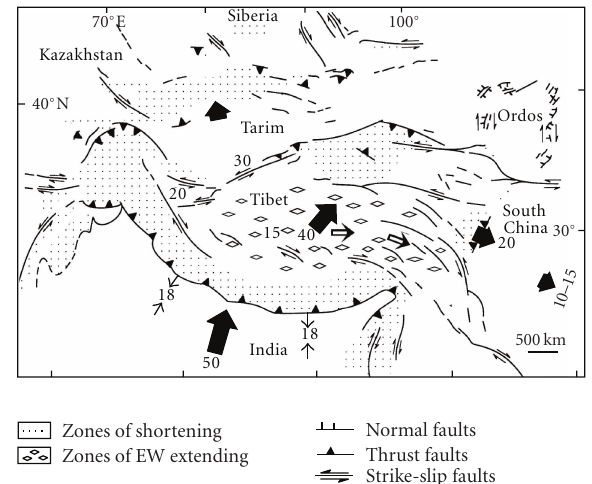
Figure 11: Eeastward extension regions on the central Tibetan plateau. Open rhomb area: extensional motion region obtained from the present analysis; open arrows: extensional direction of the plateau altitudes obtained in the present analysis (other tectonic properties are referenced the study of Avouac and Tapponnier